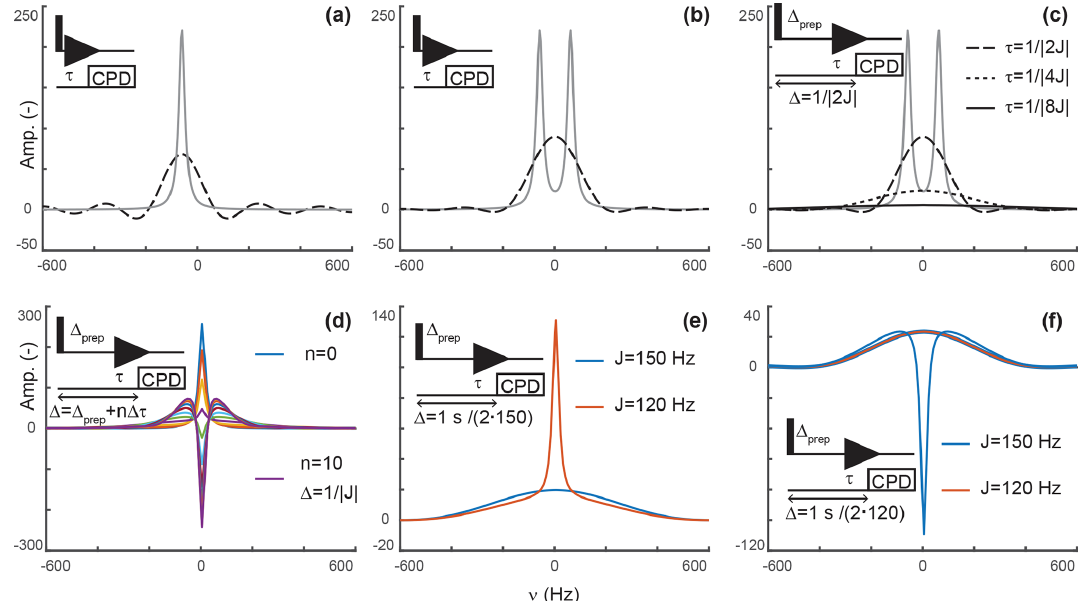
Figure 2. Principles of editing through delayed decoupling. (a) Applying decoupling once coherences are antiphase truncates their free induction decay (FID) and attenuates their signals (dashed line), as shown here for the isolated component of a doublet. (b) The two compo- nents combine into a broadened and attenuated shape (dashed line). The analytical expressions of Eqs. (2) (solid gray line) and (4) (dashed black line) were used in panels (a, b) . (c) Further attenuation is obtained when evolution into antiphase coherences is shared between a preparation period and detection as shown through simulations. The total evolution, (cid:49) , was set to 1 / | 2J | , with evolutions during detection τ = 1 / | 2J | (dashed line), 1 / | 4J | (dotted line), and 1 / | 8J | (solid line). In panels (a–c) , spectra without delayed decoupling are shown in gray for reference. (d) Simulation where the duration (cid:49) is arrayed for a fixed preparation period (cid:49) prep = 1 / | 4J | , and τ ranges from zero to 3 / | 4J | leading to (cid:49) = 1 / | J | in 10 increments (cid:49)τ of 3 / | 40J | . This simulation predicts the results seen in Fig. 4b. In panels (a–d) , J is set to 120Hz. (e) A delayed decoupling targeting 150Hz leads to residual positive in-phase signals for spins with couplings at 120Hz. (f) A delayed de- coupling targeting 120Hz leads to negative residual in-phase signals for couplings at 150Hz. In panels (e, f) , (cid:49) prep = 1 / | 4J | and τ is set to 1 / | 4J | for the targeted J, i.e., half of the total duration (cid:49)